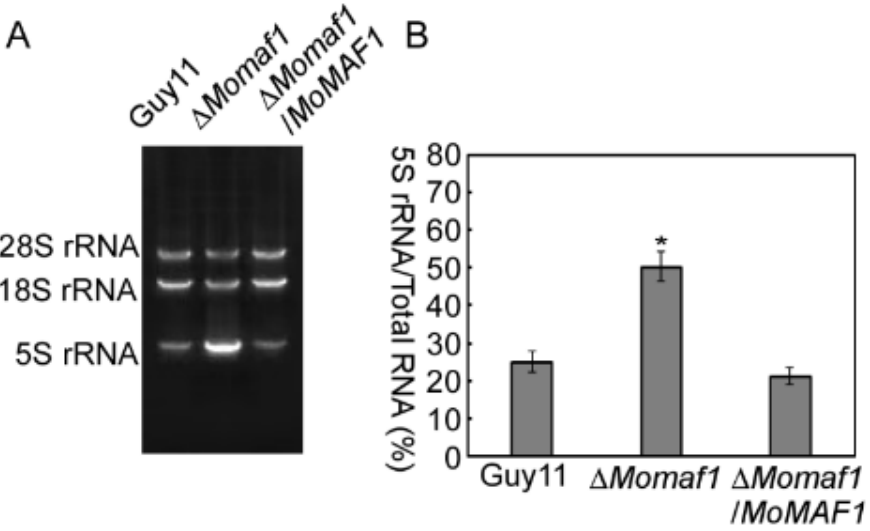
Figure 2. Total-RNA analysis of the test strains: ( A ) The Magnaporthe oryzae wild-type strain Guy11, ∆ Momaf1 mutant strain, and ∆ Momaf1/MoMAF1 strain were grown in liquid CM at 28 ◦ C for 36 h and then collected for total-RNA extraction. Total-RNA samples of 5 µ g were loaded onto a 1% agarose gel and stained with ethidium bromide before visualization. ( B ) Statistical analysis of the 5S rRNA/total RNA ratio in the different strains. Error bars represent ± SD, and asterisks indicate significant differences ( p < 0.01). Relative band intensity was quantified by IMAGEJ software. The experiment was repeated three times.